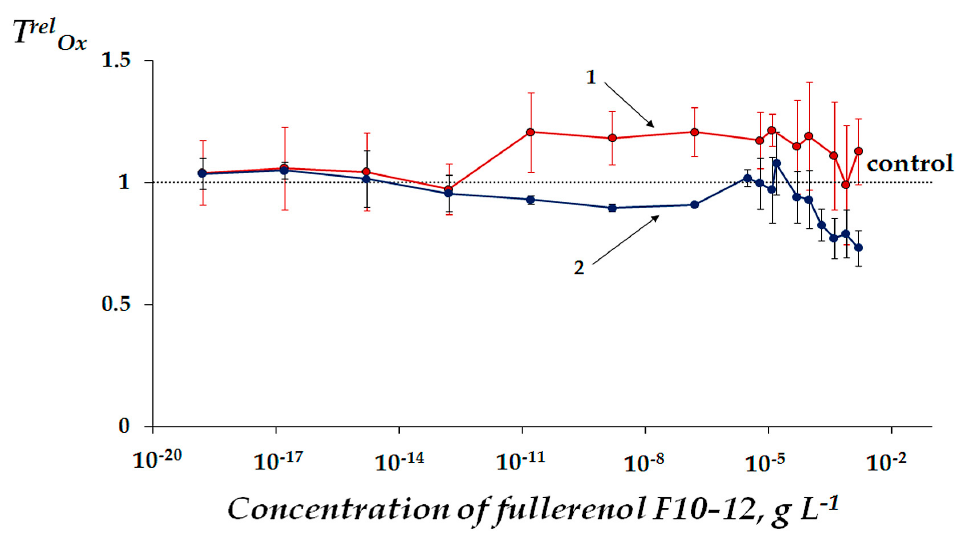
Figure 4. Antioxidant coefficients T relOx vs. concentration of fullerenol F10-12 in solutions of (1) 1,4-benzoquinone at EC 50 = 10 − 5 M and (2) K 3 [Fe(CN) 6 ] at EC 50 = 10 − 4 M.